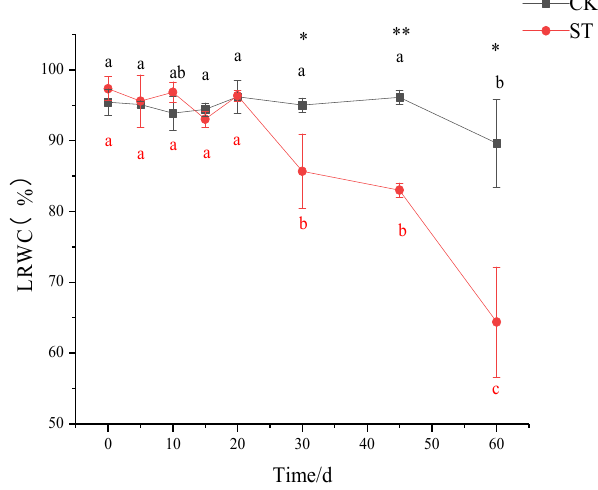
Figure 2. Response of leaf relative water content (LRWC) in the seedlings of C. hongkongensis subsp. tonkinensis to salt stress. * and ** indicate a significant difference between CK and ST at the same time according to the independent-samples t -test ( p < 0.05, 0.01); different lowercase letters indicate significant differences among tested time within treatment ( p < 0.05) according to one-way analyses of variance (ANOVAs). The same is below. Table 2. Response of biomass allocation in the seedlings of C. hongkongensis subsp. tonkinensis to salt ‐ stress for 60 days.